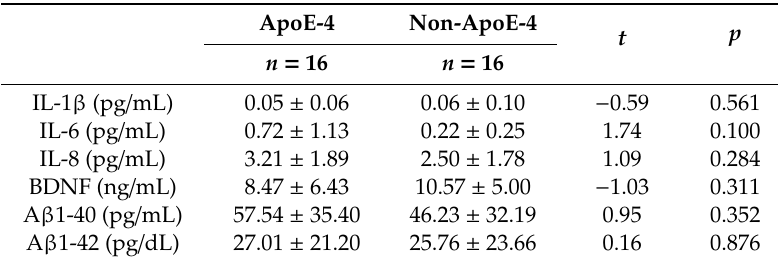
Table 2. Biochemical values (mean ± SD) of the ApoE-4 and non-ApoE-4 groups.